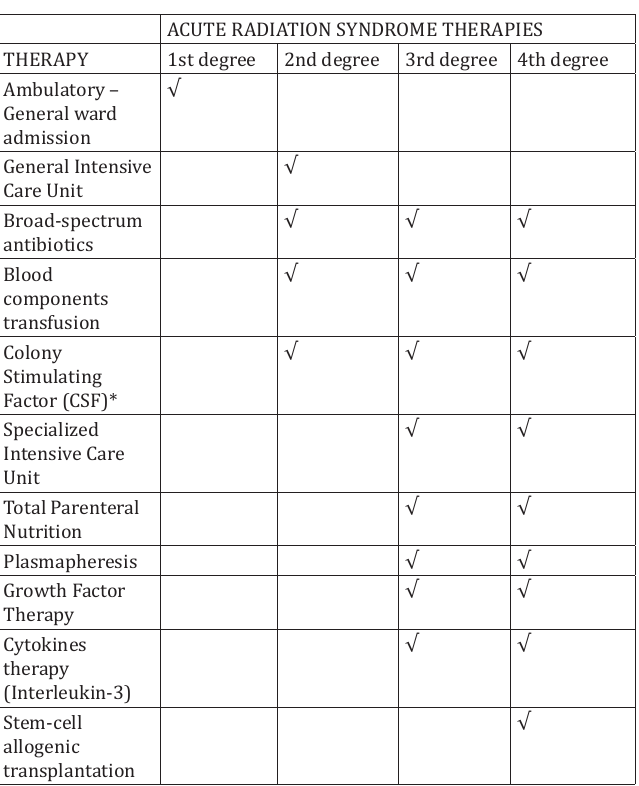
ARS therapies according to severity of the